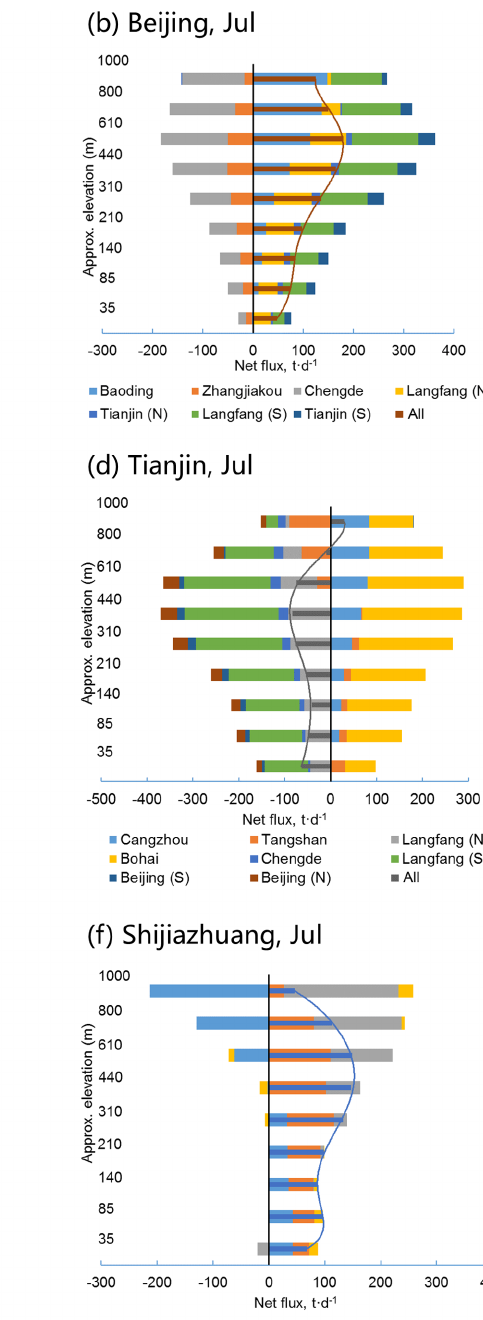
a southerly transport pathway during pollution periods in the indeed important in this particular